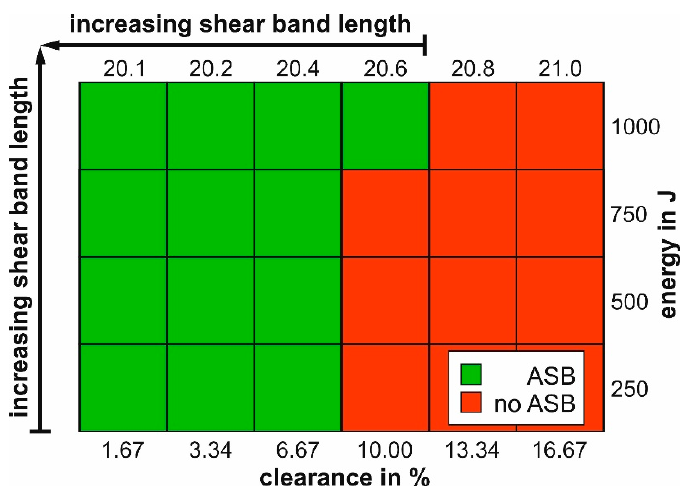
Figure 4. Process windows of the blanking tests performed with varying clearance and impact energies and their influence on the formation of an ASB.